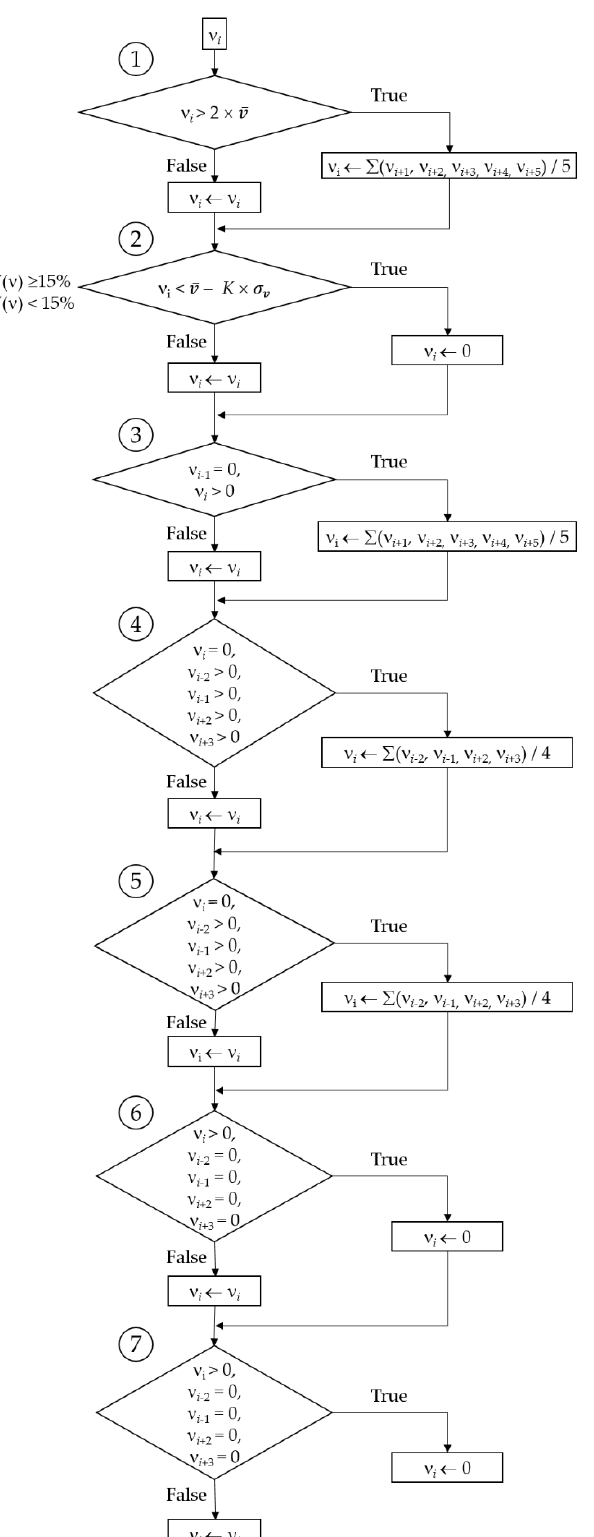
Figure 1. Block diagram illustrating the speed ( ν ) data processing methodology. v , σ v , CV( ν ) are the mean, standard deviation, and coefficient of variation of speed over the representative 120-s (or shorter if not possible) period of the session; ν i is the speed value corresponding to the epoch i . At each of the seven steps, ν i outputs ( ν i ← ) are new values that are included in a new vector ν